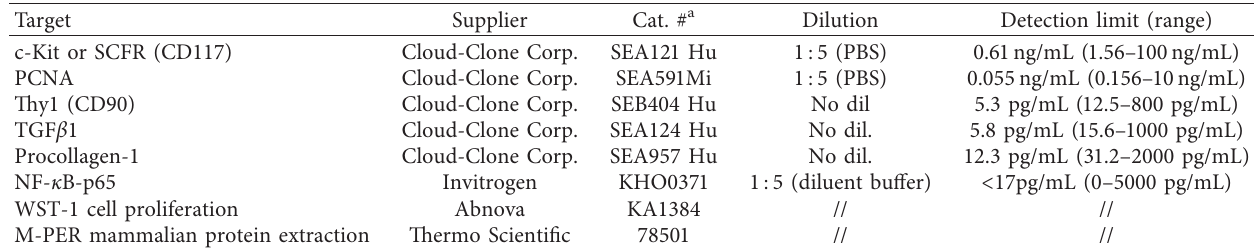
Table 2: List of ELISA tests, cell proliferation, and protein extraction kits used. For ELISA tests, dilution of the supernatants or cell lysate samples used and detection limits are also